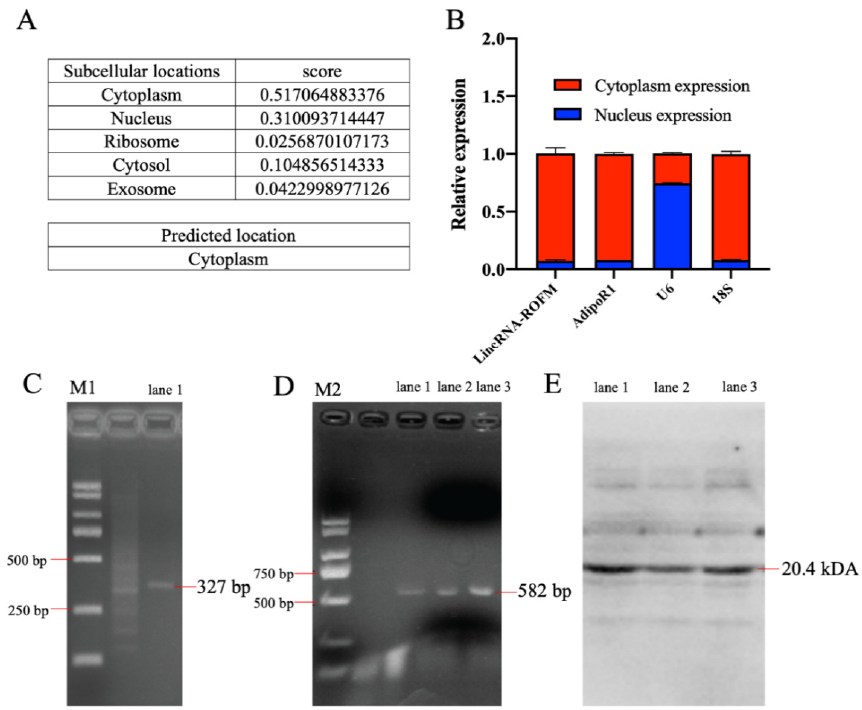
Figure 4. LincRNA-ROFM is mainly located in cytoplasm of porcine preadipocytes and no coding ability. ( A ) The subcellular localization of LincRNA-ROFM by Lnclocator online software. ( B ) The relative expression level of LincRNA-ROFM in cytoplasm and nucleus of porcine preadipocytes by RT-qPCR. U6 as an internal reference in the nucleus, 18S was used as a cytoplasmic reference and AdipoR1 was used as a negative control. ( C , D ) The results of LincRNA-ROFM ORF detected by Agarose gel detection PCR. Note: LincRNA-ROFM ORF1 is 327 bp ( C ); LincRNA-ROFM ORF2 is 582 bp ( D ), and marker is DL 2000. ( E ) The coding ability of LincRNA-ROFM detected by WB. Note: lane 1: pET-32a ; lane 2: LincRNA-ROFM ORF1 and lane 3: LincRNA-ROFM ORF2.